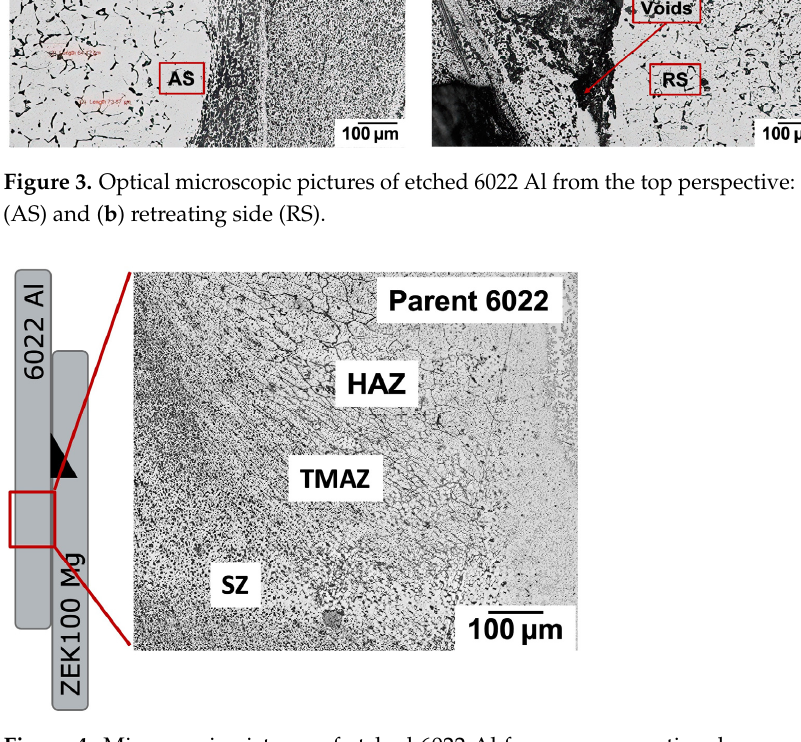
Figure 4. Microscopic pictures of etched 6022 Al from a cross-sectional perspective shows distin- guished zones.